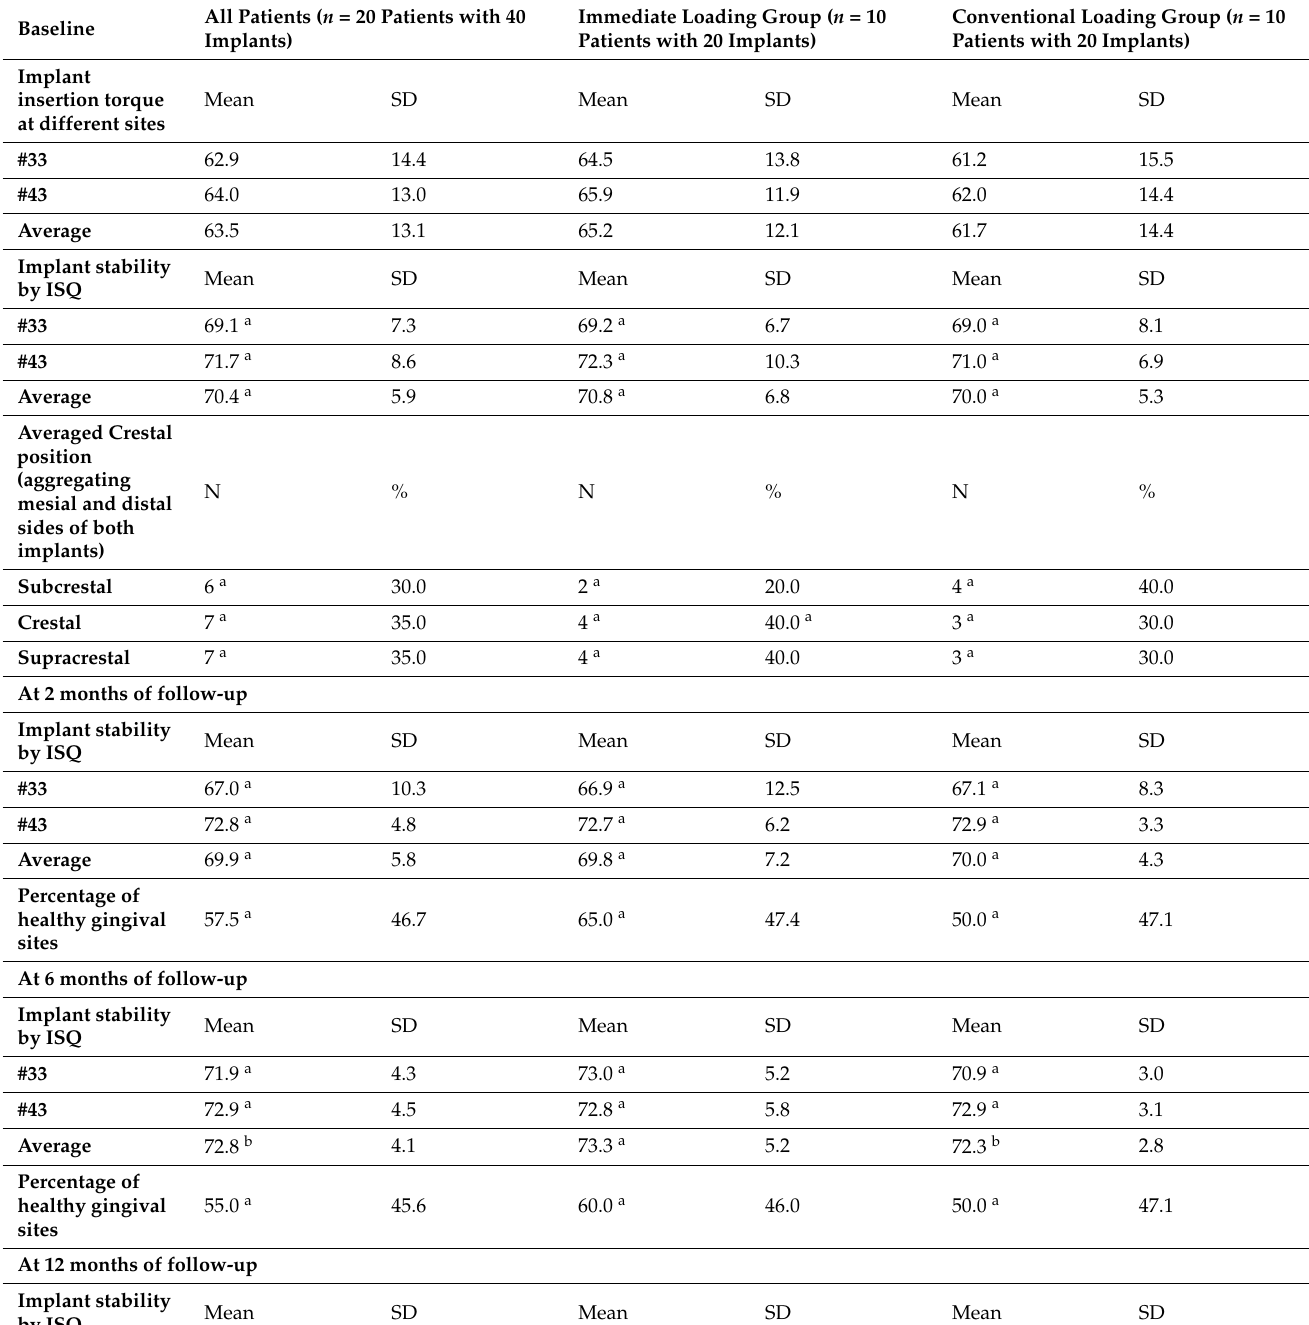
Table 2. Distribution and variation of longitudinal implant-related variables in the study sample ( n = 20). Comparisons by paired and unpaired Student’s t